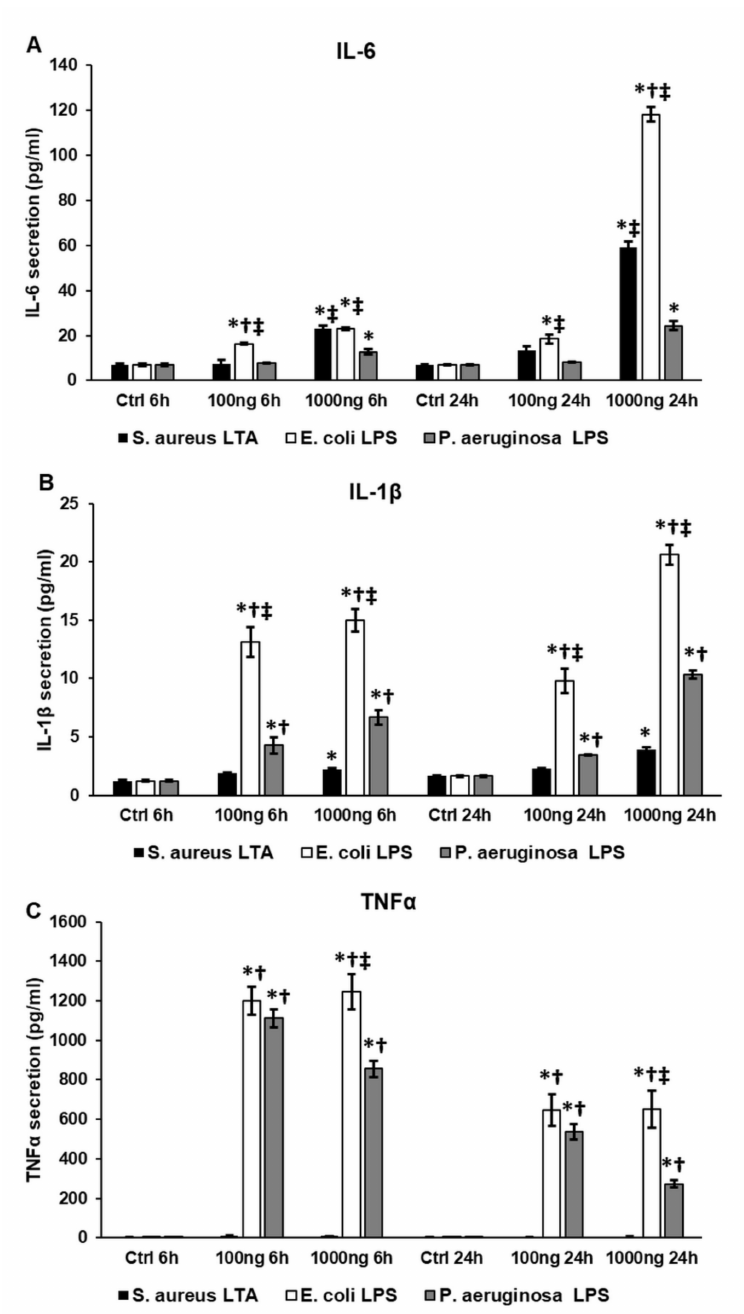
Figure 1. Concentration measurements of pro-inflammatory cytokines of lipopolysaccharide (LPS)- and lipoteichoic acid (LTA)-treated THP-1 cells. Secreted IL-6, IL-1 β and TNF- α concentrations of the culture media were determined with human IL-6, IL-1 β and TNF- α ELISA kits according to the instructions of the manufacturer. ( A ) Secreted IL-6 concentration of THP-1 cells treated with S. aureus LTA, E. coli LPS and P. aeruginosa LPS. ( B ) IL-1 β production of THP-1 cells treated with LTA and LPS isolated from different sources. ( C ) TNF- α secretion of LTA- and LPS-treated THP-1 cells. The columns represent mean values and error bars represent standard deviation (SD) of three independent determinations ( n = 3). ELISA measurements were carried out in triplicate in each independent experiment. An asterisk * indicates p < 0.05 compared to the controls. A cross † indicates p < 0.05 compared to LTA treatment and a double cross ‡ shows p < 0.05 compared to P. aeruginosa LPS